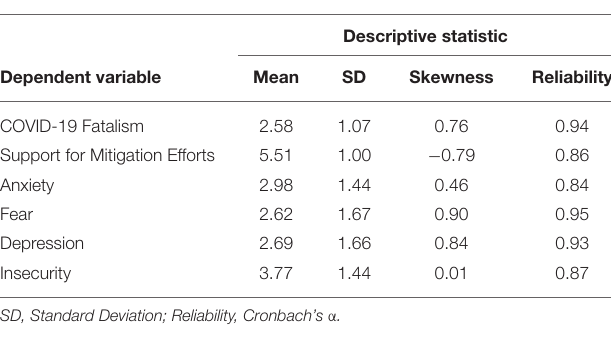
FIGURE 2 | Effect of Messaging Condition on Support for COVID-19 Mitigation